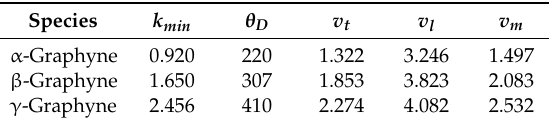
Table 3. The minimum thermal conductivity k min [W/(m · K)], Debye temperature θ D (K), average acoustic transverse wave velocity v t , average acoustic longitudinal wave velocity v l , average acoustic wave velocity v m (km s − 1